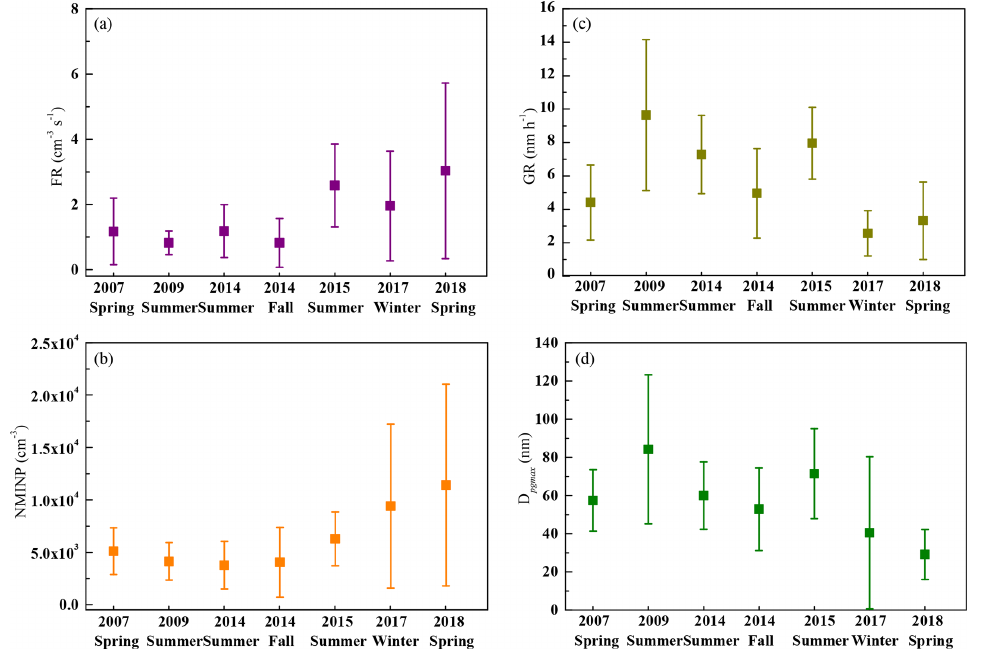
Figure 3. Campaign average of the new particle formation rate (FR, a ), the net maximum increase in the nucleation-mode particle number concentration (NMINP, b ), the new particle growth rate (GR, c ), and the maximum geometric median diameter of the grown new particles ( D pgmax , d ) during the seven observation campaigns. The error bars are the standard